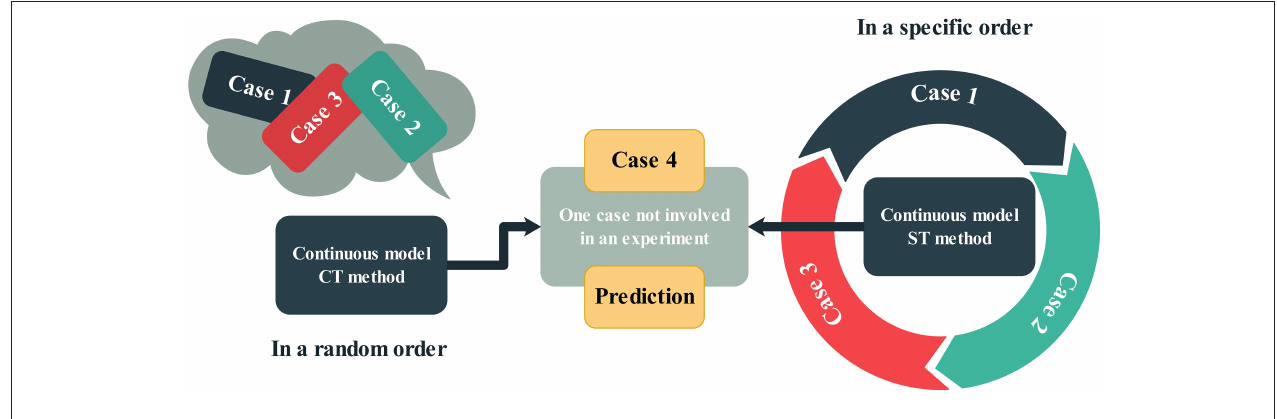
FIGURE 7 | Two training method in Continuous model.